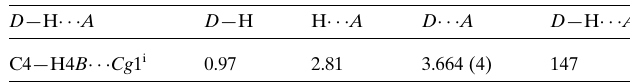
Table 1 Hydrogen-bond geometry (A˚ , (cid:3) ). Cg 1 is the centroid of the bezne ring.